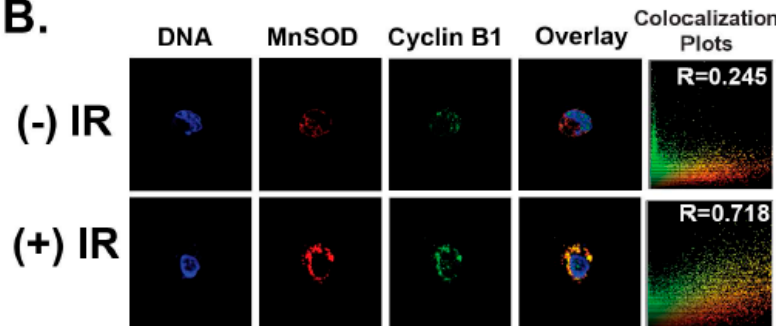
Figure 1. Cyclin B1 mitochondria translocation. ( A ) Representative images of confluent normal human skin fibroblasts (NHFs): NHFs were re-plated and irradiated at 18 h post-plating (representative of late S and G 2 phases) with 1–6 Gy (dose rate: 0.89 Gy/min) ionizing radiation (IR). At 4 h post-irradiation, monolayer cultures were fixed and processed for immunostaining and confocal microscopy; TO-PRO3 (nuclear, blue staining), MnSOD (mitochondria, red staining), cyclin B1 (green staining), and overlay images of MnSOD and cyclin B1; co-localization plots show red and green overlapping distributions and calculated Mander’s Overlap coefficient (R). When the red/green ratio closer to 1, they are considered correlated and co-localized. The bottom panel represents NHFs treated with 250 µM hydrogen peroxide for 1 h. ( B ) Representative images of exponentially growing asynchronous cultures of human non-malignant mammary epithelial cells (MCF10A), irradiated with 6 Gy and harvested at 4 h post-irradiation for immunostaining and microscopy assay.